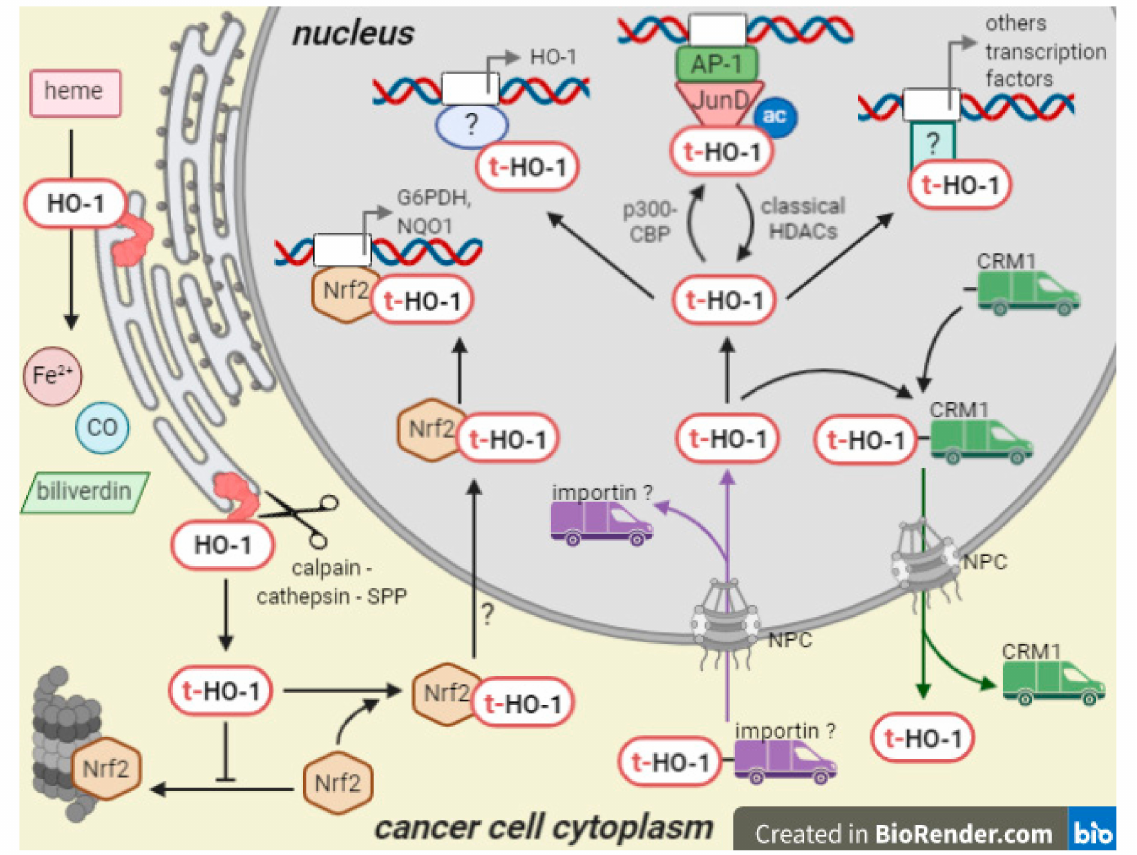
Figure 3. Mechanism of action of nuclear HO-1. Enzymatically active HO-1 is proteolitically cleaved from the sER and the generated t-HO-1 form migrates to the nucleus. Nuclear import of t-HO-1 is probably carried out by interaction with an importin, whereas nuclear export is carried out by interaction with CRM-1. Inside the nucleus, t-HO-1 may be acetylated by p300/CBP, binds to transcription factor as Nrf2 and AP-1 and activate them in order to transcribe genes related with antioxidant defenses and cell proliferation, among